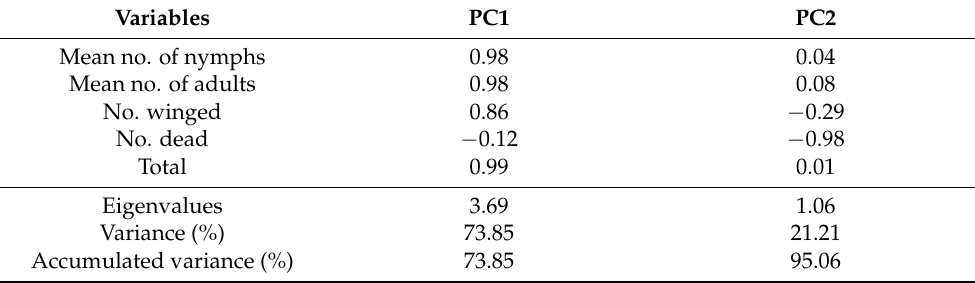
Table 1. Factor-variable correlations in the first two main components for eight sugarcane cultivars regarding the biological performance of M. sacchari under no-choice conditions. Data submitted to multivariate exploratory analysis by principal components